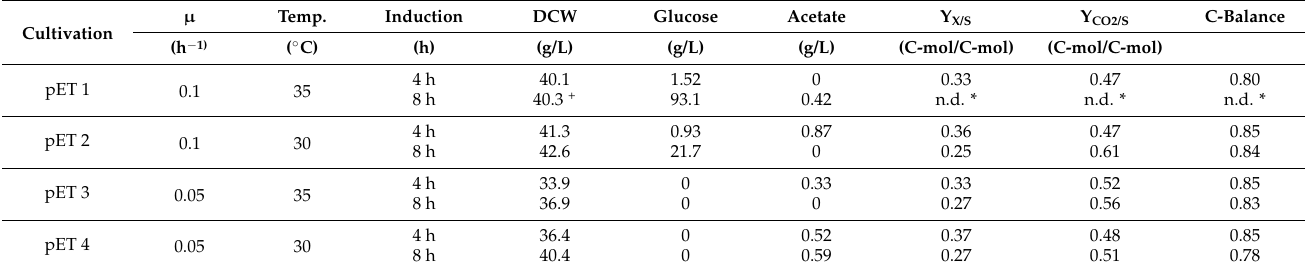
Table 1. Strain physiological parameters for pET cultivations.